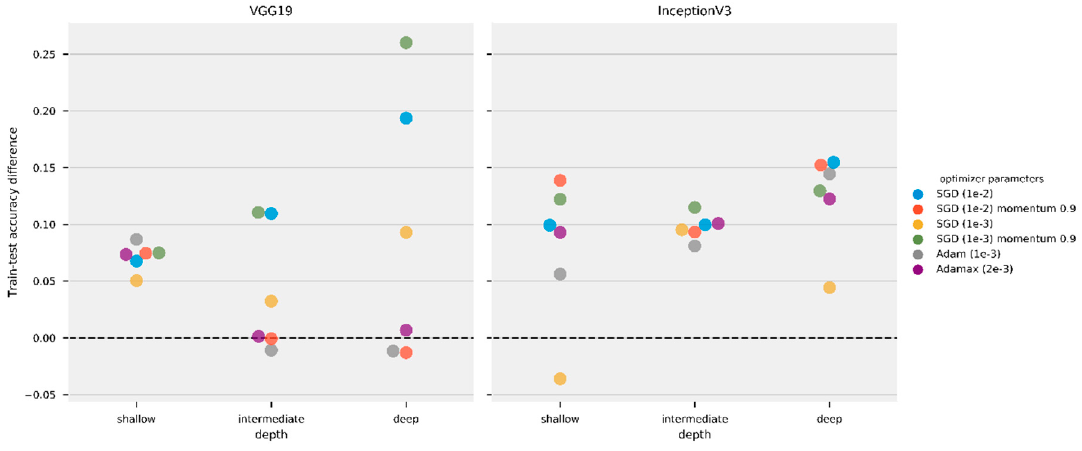
Figure 5. Difference between training set and test set accuracy obtained by the models using different optimizers training on the same UCMerced dataset. The left panel shows VGG 19 results, right panel shows Inception V3 results. Note, as shown in Figure 4, that SGD (1e-2), Adam (1e-2), and Adamax (2e-3) results of theVGG19 intermediate and deep models remained stuck on local minima.